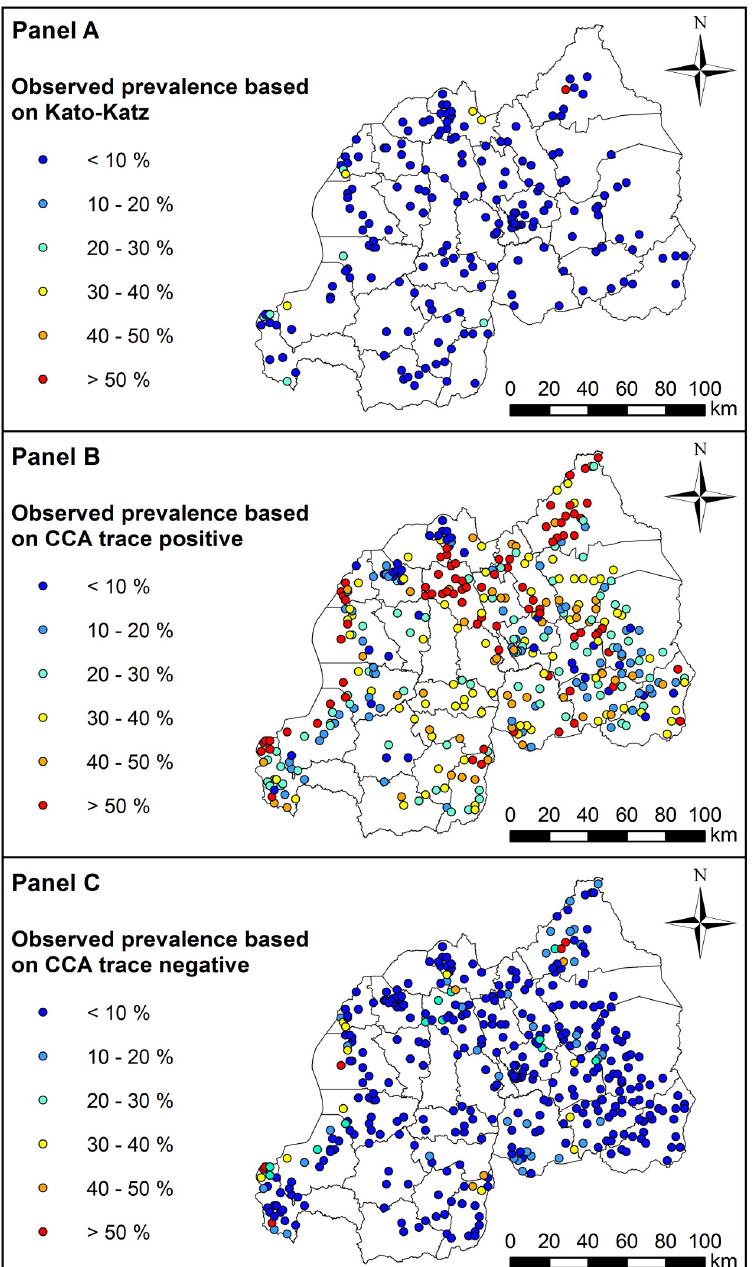
Fig 1. Observed prevalence of Schistosoma mansoni infection in Rwandan schoolchildren estimated using three different diagnostic methods: Kato-Katz (Panel A), CCA with trace as positive (Panel B), and CCA with trace as negative (Panel C). Refer to S3 Fig in Supporting Information for names of geographical districts. This figure was produced in ArcMap 10.4 (ESRI, Redlands, CA) using a shapefile representing Rwanda’s current administrative units (obtained from the geographic data warehouse DIVA GIS (www.diva-gis.org/Data)). CCA; Circulating Cathodic Antigen.